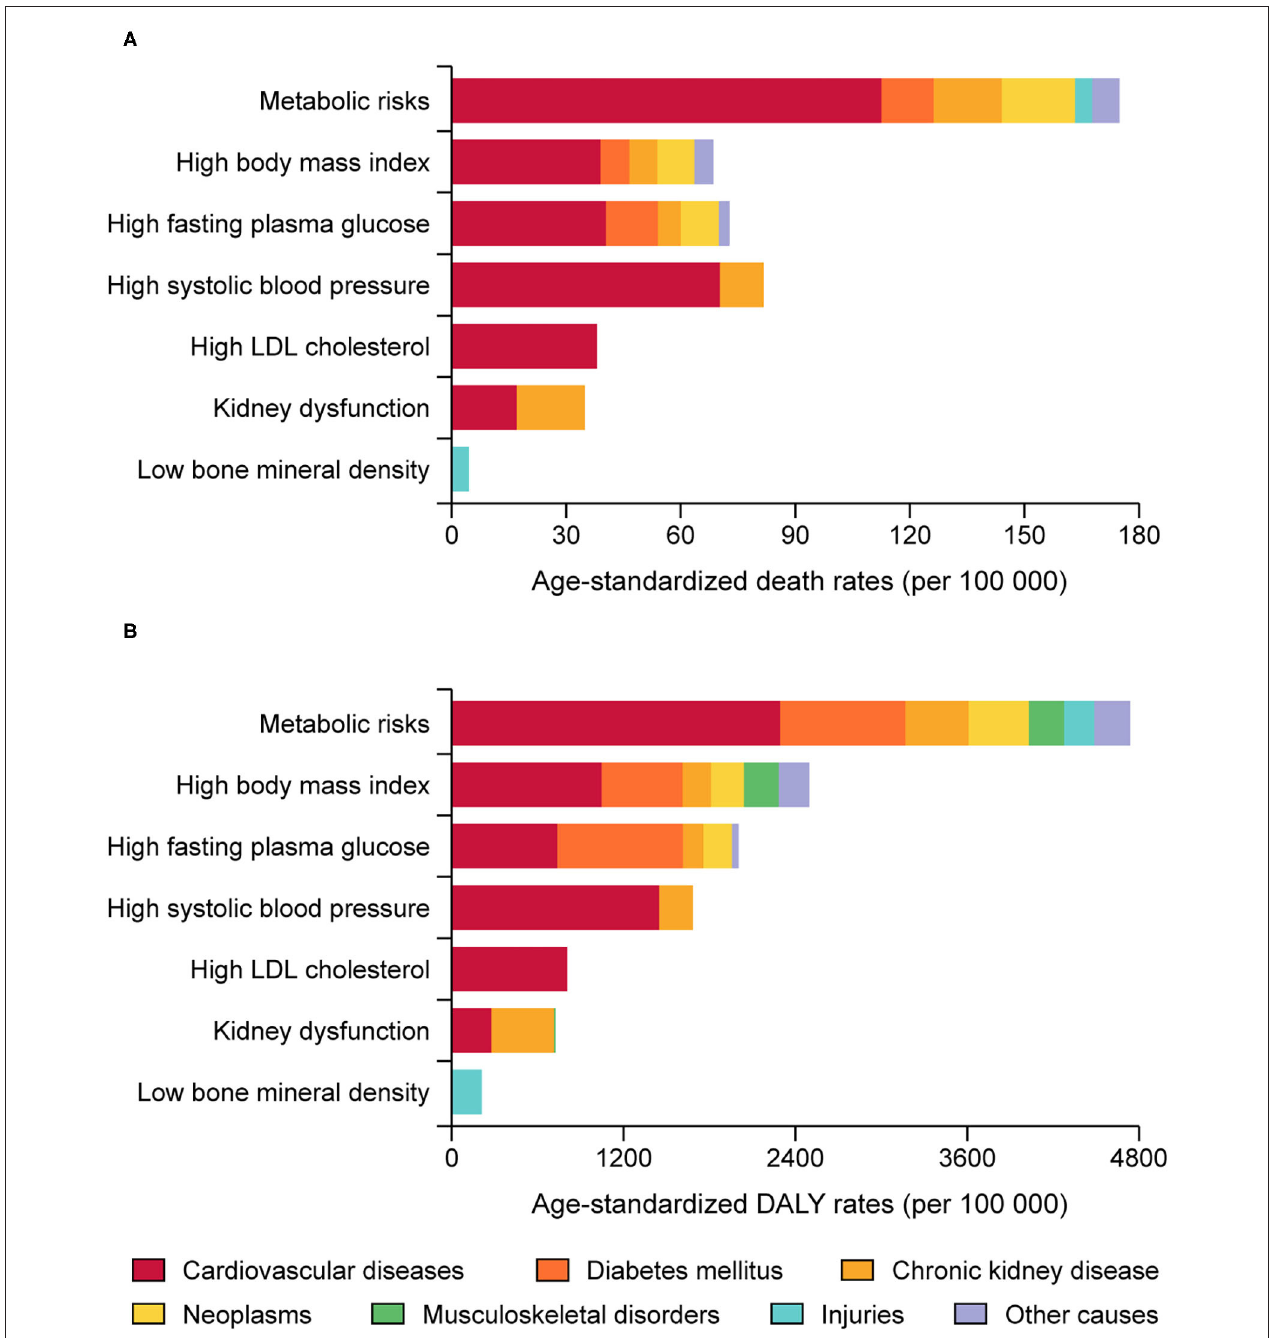
FIGURE 5 | Death (A) and DALYs (B) attributable to the individual and combined effects of metabolic risks in the United States by